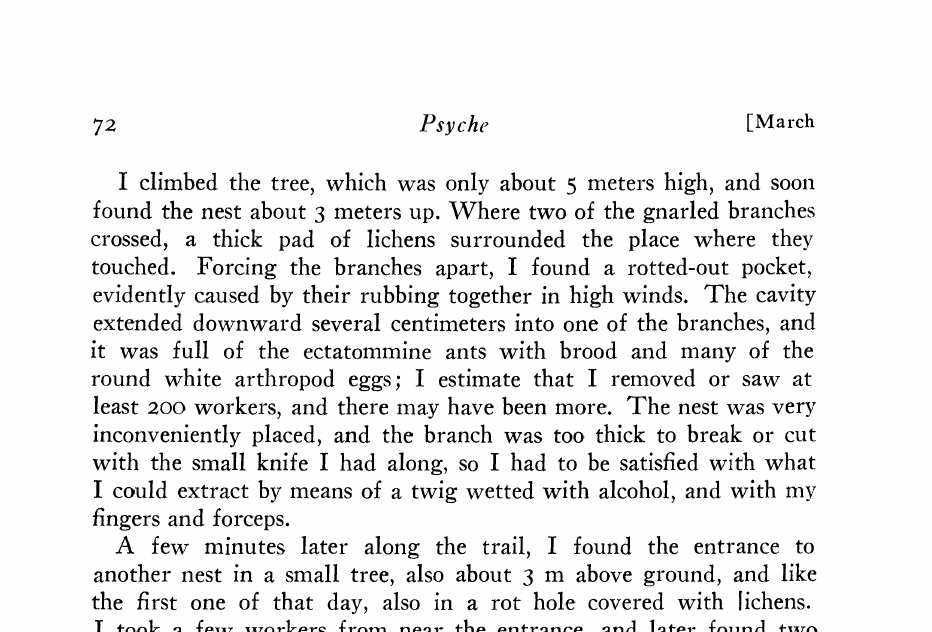
Holotype worker: TL 4.8, HL 0.96, HW 0.94 (CI 98), ML o.32, scape L o.93, greatest diameter of eye o.o9, WL 1.43, L petiole in side view o.6o, L petiolar node as seen from above o.47, W petiolar node o.47, L hind tibia o.97, L hind metatarsus o.8I ram. For head length (HL), measurement is taken from the anterior lateral corners of the head (clypeus) head width (HW)